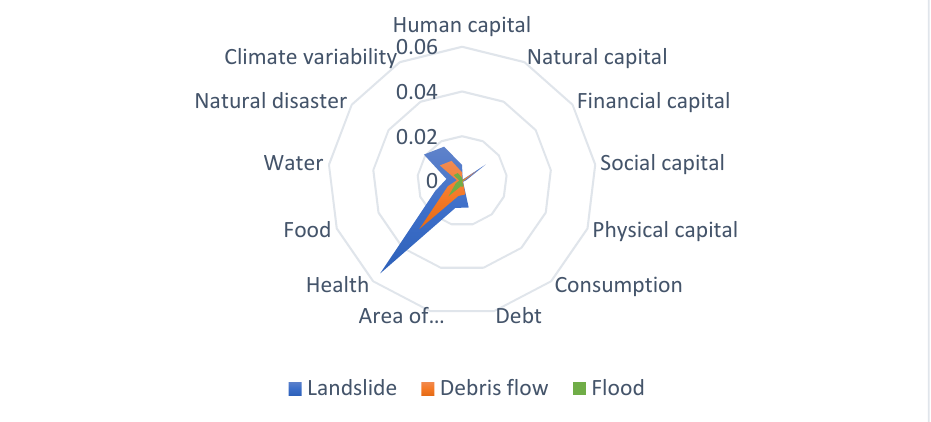
Figure 3. Spider diagram of the major components of IPCC-LVI for different types of disasters.